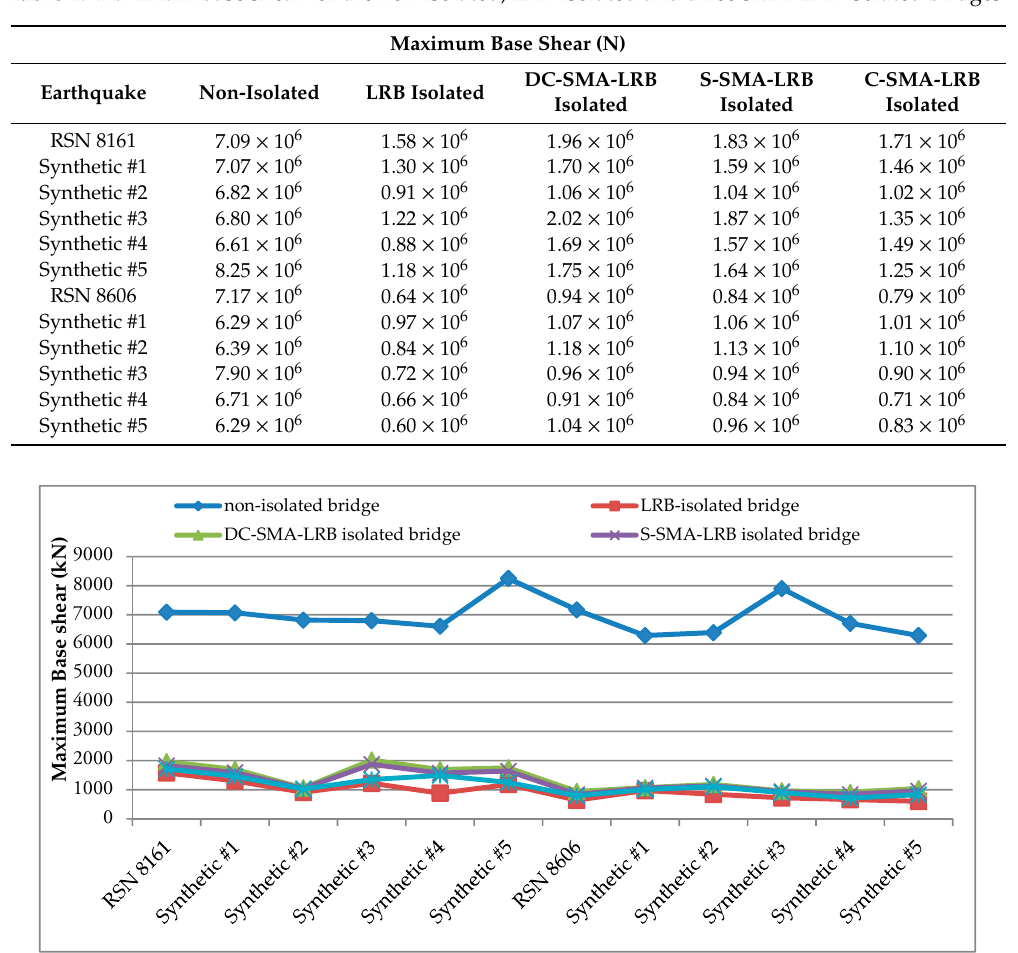
Table 4. Maximum base shear for the non-isolated, LRB-isolated and three SMA-LRB isolated bridges.